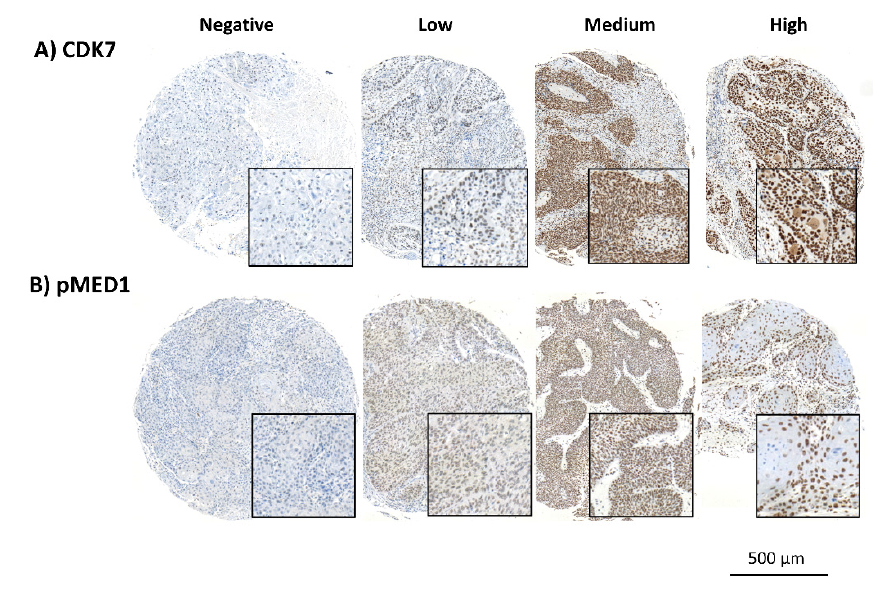
Figure 1. Expression patterns for ( A ) CDK7 and ( B ) pMED1 in our HNSCC cohort (magnification 20 × , insert 30 × ). TMAs were immunohistochemically stained for CDK7 and pMED1. The cancer specimen showed a variation in protein expression. The expression of the proteins was homogenous within the patients’ samples, meaning there was little disparity within the staining of cells in a single core. In some HNSCCs the cancer cells showed no staining and accordingly protein expression was considered negative. Throughout the cohort a range of staining intensities was obtained, ( A , B ) illustrate samples of a negative, low, medium, and high protein-expressing tumor specimens. Table 1. Overview of clinical characteristics of CDK7 high and low